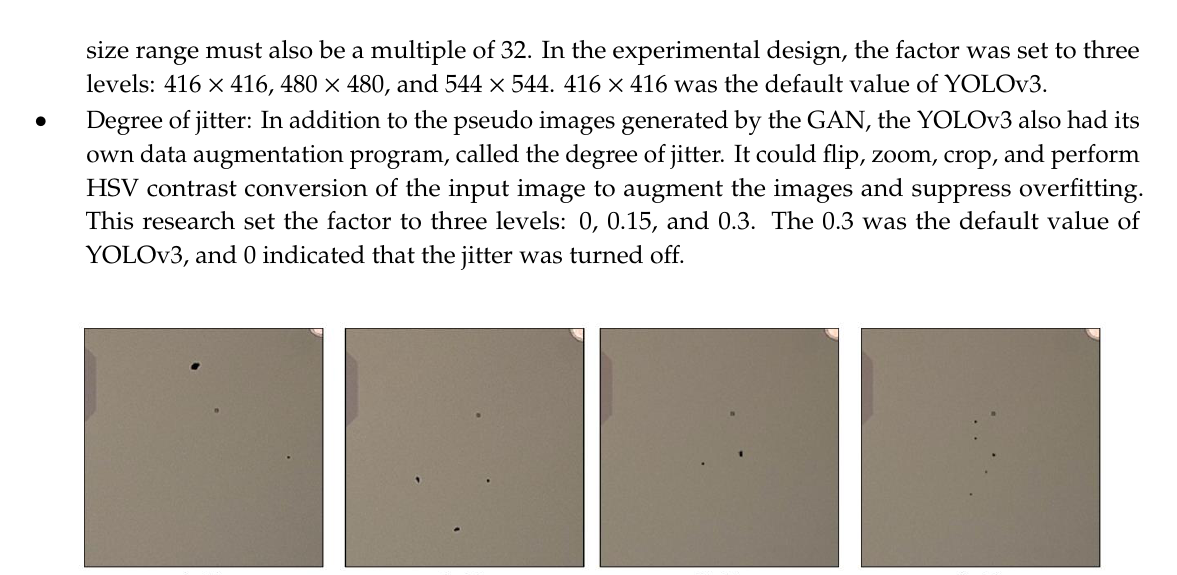
Figure 5. Comparison of defect images. ( a1 , a2 ) Original defects and ( b1 , b2 ) pseudo defects.